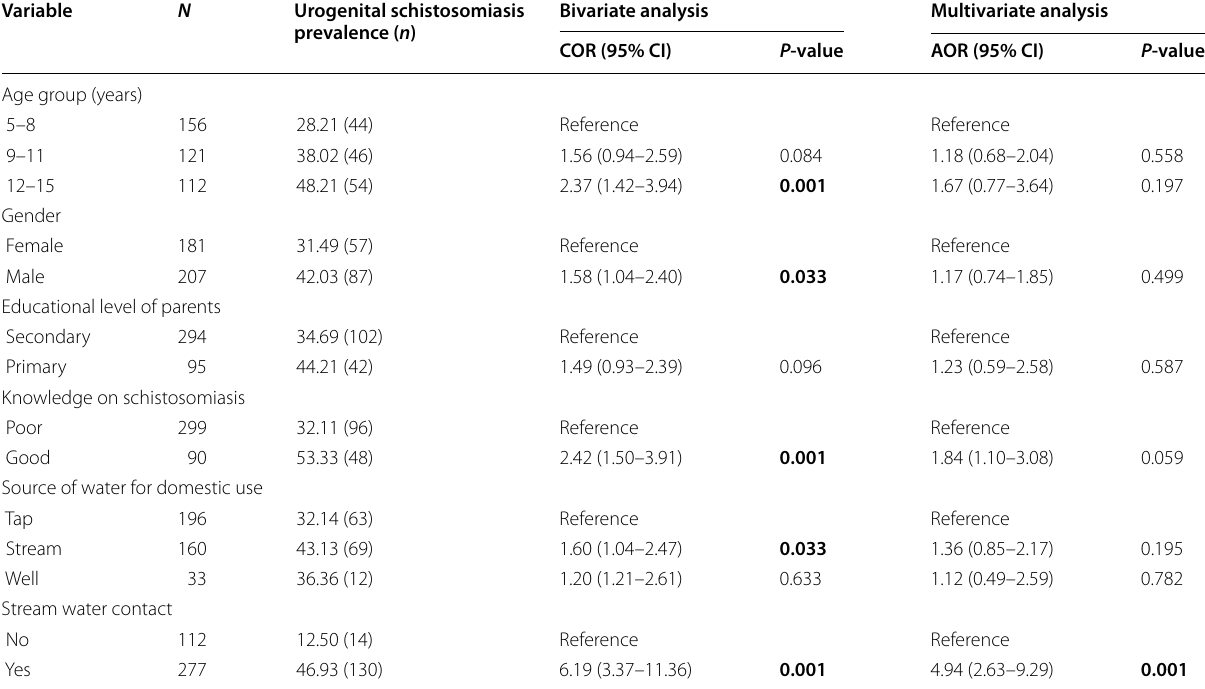
UGS, egg/haematuria positive; COR, crude odds ratio; AOR, adjusted odds ratio; P values in bold are statistically